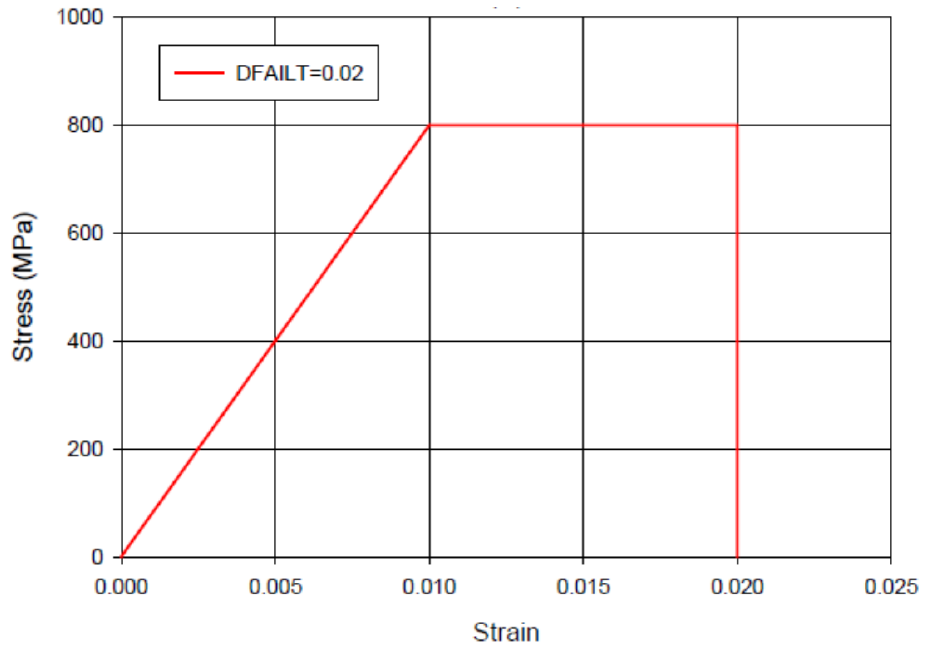
Figure 2. Stress – strain curve in fibre direction under tension, DFAILT = 0.0 [51].